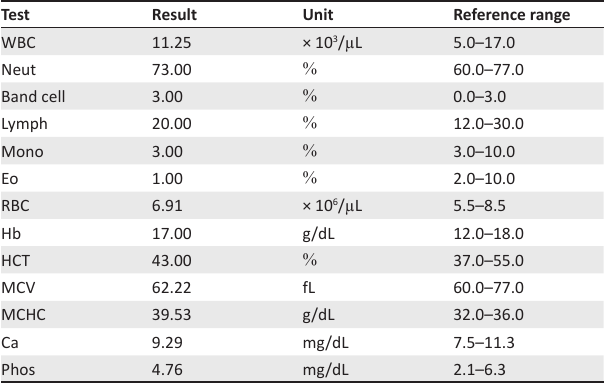
TABLE 1: Haematological and biochemical parameters as identified in this case study. Test